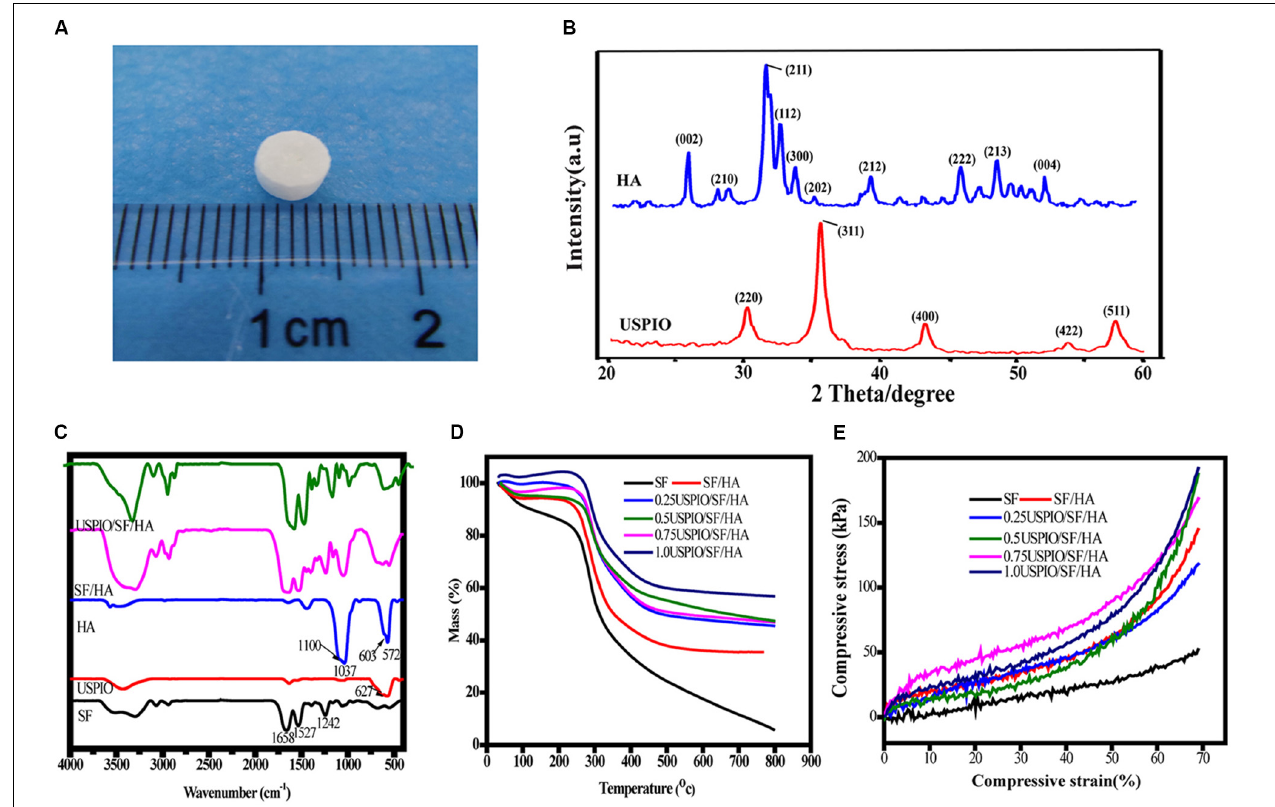
FIGURE 2 | Characterization of scaffolds with different amounts of USPIO incorporated (0–1, w/w%). Gross observation of scaffold (A) , X-ray diffraction of HA and USPIO nanoparticles (B) , Fourier transform infrared spectroscopy (C) , Thermogravimetric analysis (D) , and Stress–Strain curve (E) .